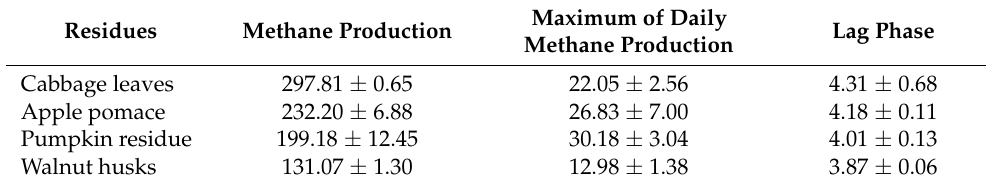
Table 2. Methane production (NL kg VS − 1 ) and lag phase (days) of studied residues during 30 days of the